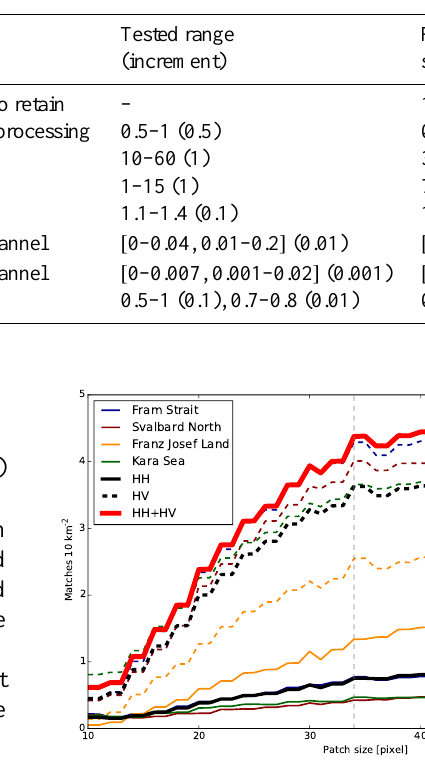
Figure 2. Patch size of descriptor vs. number of matches of the four test image pairs from Table 1. Solid and dashed lines represent results for HH and HV polarization respectively. Mean values of the four image pairs are shown in black and the sum of the mean values in red. Vertical grey line at 34 pixels represents chosen